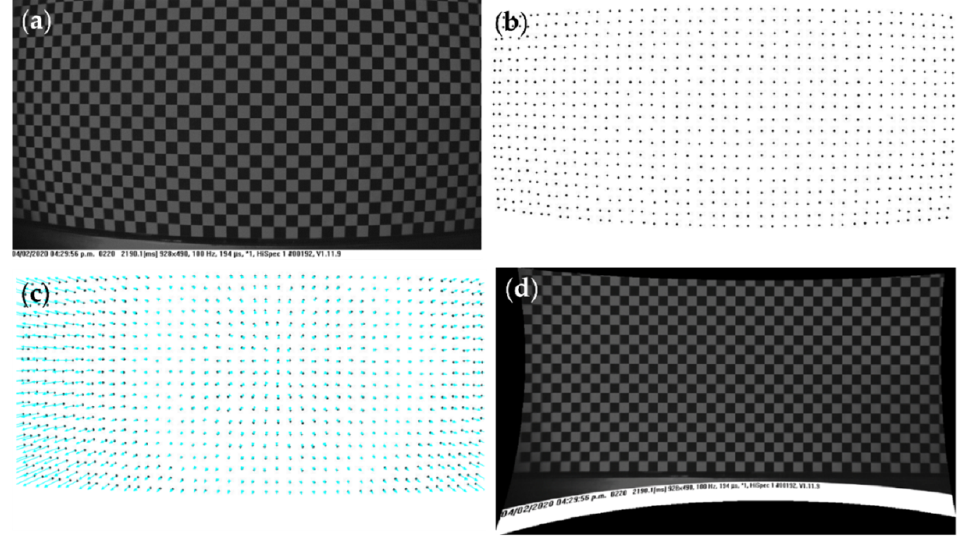
Figure 2. Stages during image calibration and rectification: ( a ) input calibration image; ( b ) detected corners; ( c ) error estimation; ( d ) image calibration and